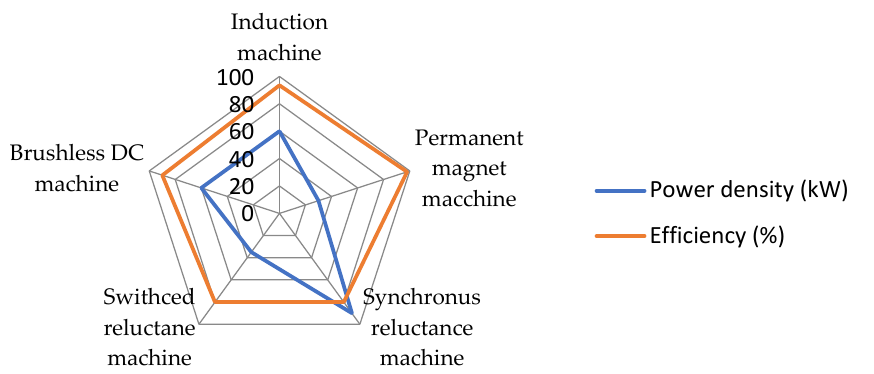
Figure 4. Spiderchart representation of different EMs performance